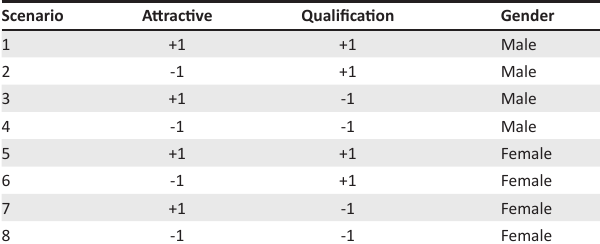
TABLE 1: Summary of knowledge worker job application